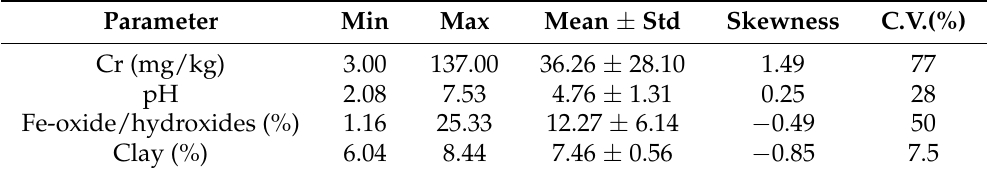
Table 2. Descriptive statistics of the soil attributes.